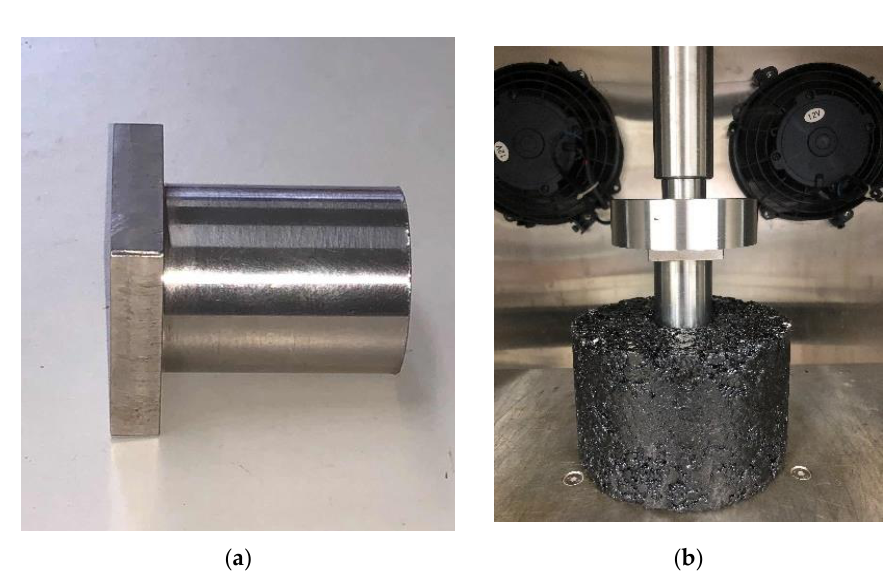
Figure 3. Uniaxial penetration shear test: ( a ) metal column; ( b ) experiment photo.